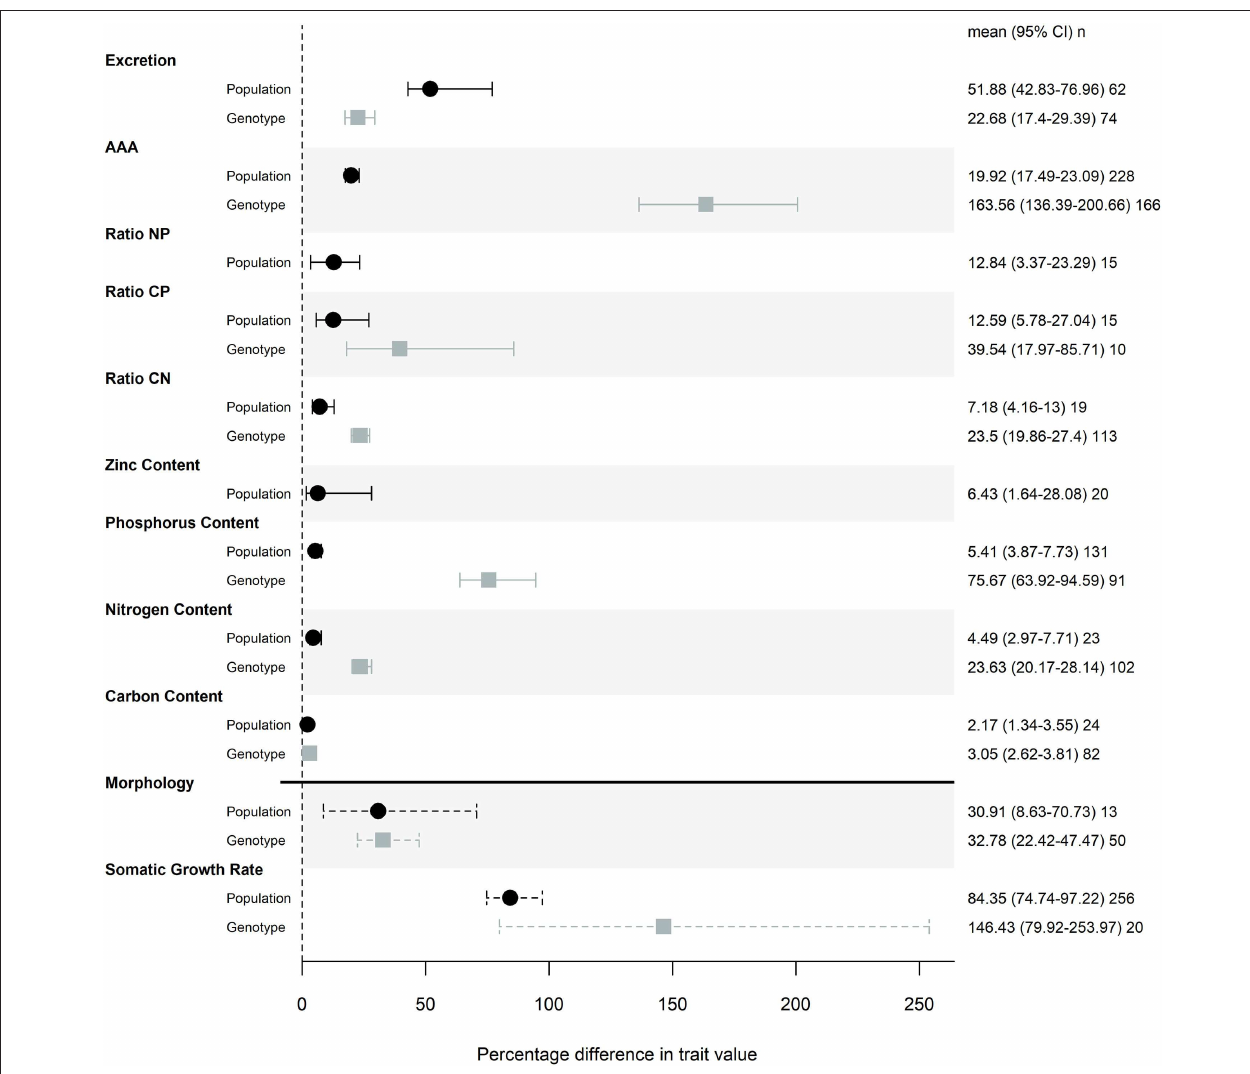
FIGURE 1 | Magnitude of trait differences among pairs of populations (black) or genotypes (gray) grown in the same common garden. Points represent the mode of the posterior distribution and error bars are 95% credible intervals of the effect sizes. Posterior distributions of effects were taken from models that included common garden nested in study as a random effect, and the posterior distributions were transformed with a folded normal distribution to obtain the magnitude of difference between pairs of populations or genotypes. Percentage difference in trait values were calculated by back-transforming the mean effect sizes. n represents the number of pairwise comparisons used to calculate each effect size. Somatic growth rate and morphology (measures of mass and size) effect sizes are denoted with a dashed line to indicate that this meta-analysis is not a comprehensive review of common garden experiments that measured these